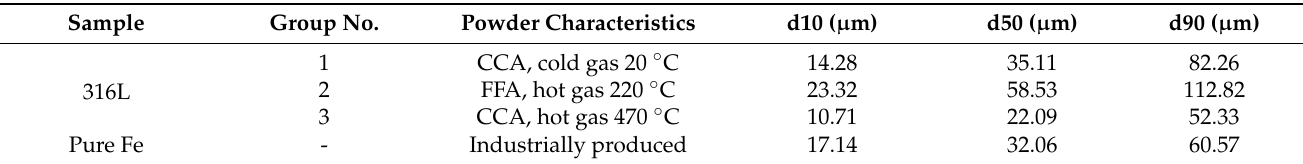
Table 3. Particle size distribution of the 316L steel powder produced by three argon gas atomisation routes and industrially produced pure Fe powder.